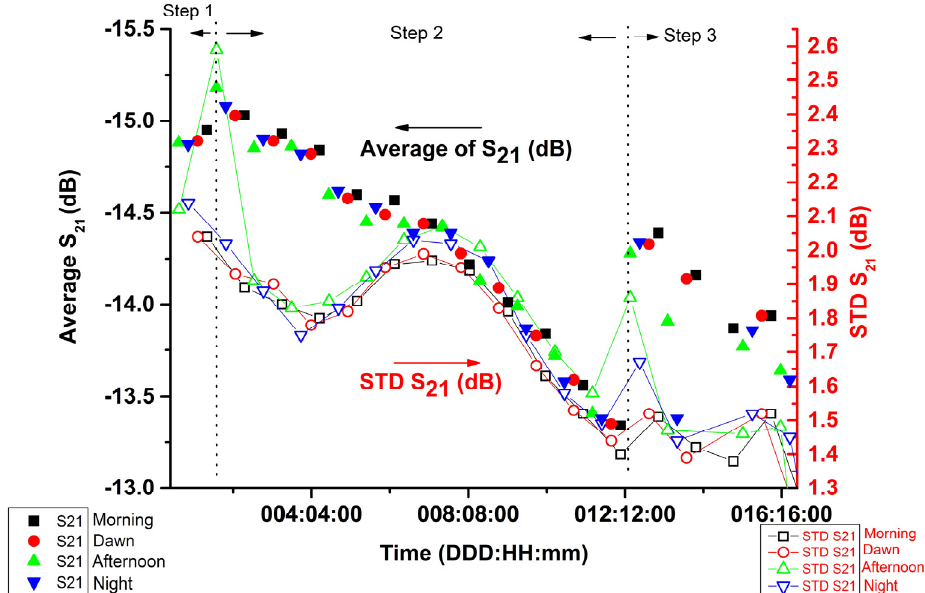
Figure 10. Results of the measurement of S 21 attenuation that correlate with volumetric soil moisture in the rhizobox, during the time of 16 days, 21 h and 17 min and a calculation of standard deviation (STD S 21 ). The sample is the Kaktus soil with maize. The experiment was organized in three steps to measure the attenuation of soil moisture during the time of root growth. The measurement was taken in standard laboratory conditions (Temperature (T( ◦ C)) = 24.3 ± 1.1 ◦ C and Relative Humidity (RH(%)) = 62.8% ± 5.0%) at dawn (3:00 am), in the morning (9:00 am), in the afternoon (3:00 pm) and at night (9:00 pm).